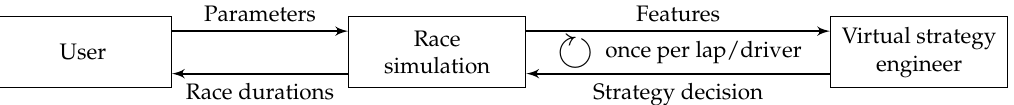
Figure 15. Overview of the integration of the virtual strategy engineer into the race